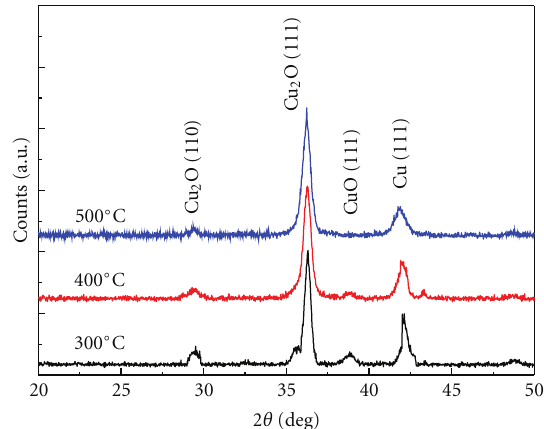
experiments the RF power and the gas pressure were kept constant at 50 W and 3.1 × 10 − 3 Torr, respectively. The Cu 2 O Figure 2: X-ray di ff raction patterns of the samples with thermal oxidation at various